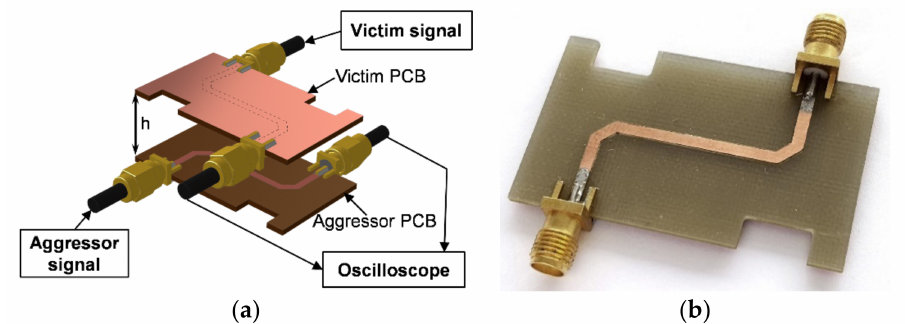
Figure 9. ( a ) Wiring diagram of the measurement setup; ( b ) photo of the device under